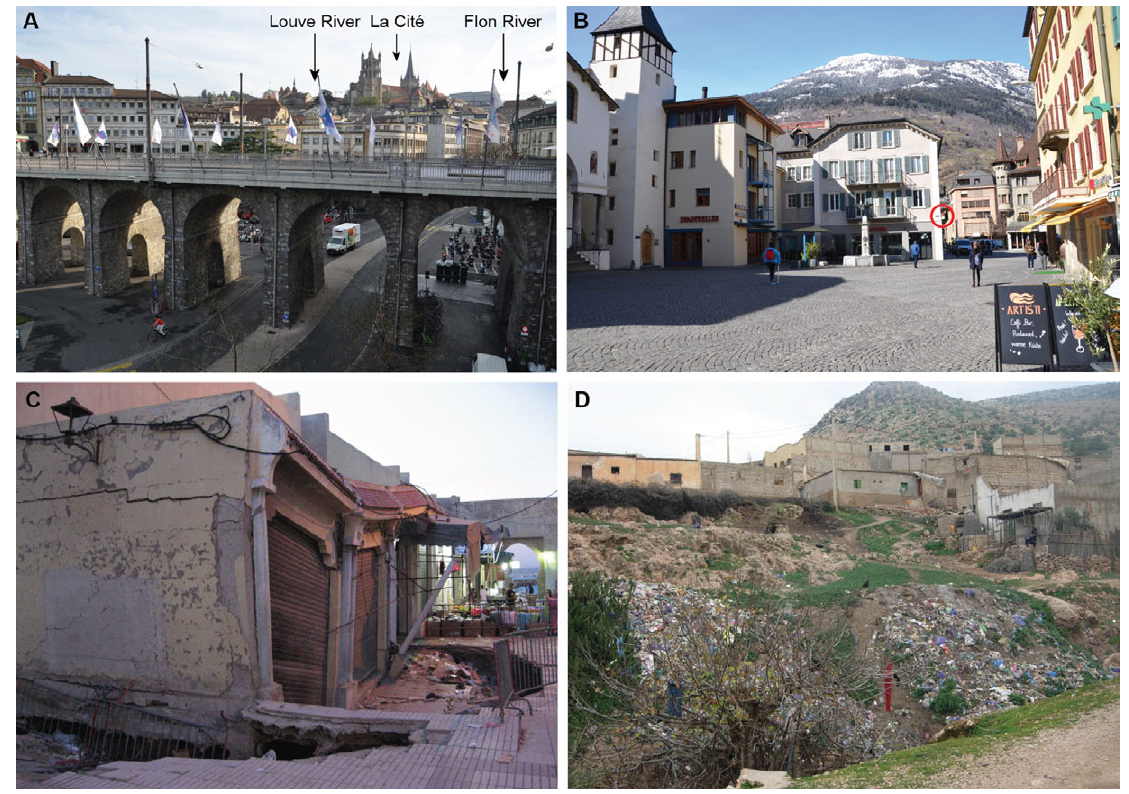
Fig. 2. Example of relationships between geomorphology and